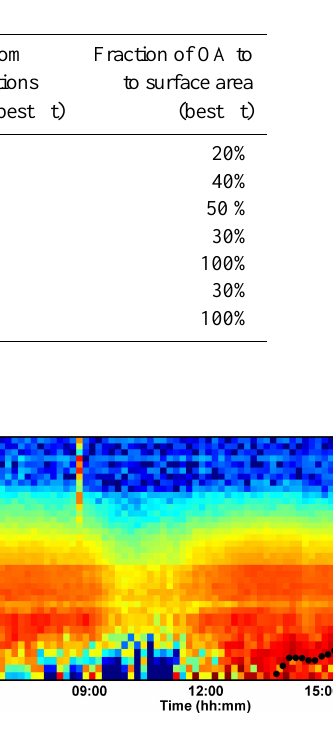
Fig. 8. The contribution of low-volatility material to the nucleation mode growth in Hyyti¨al¨a during an atmospheric nucleation event on 15 April 2007. The particle size distributions measured with the V-DMPS system after the ambient aerosol sample has been heated to 280 ◦ C. The black dots represent the geometric mean size of the growing nucleation mode after